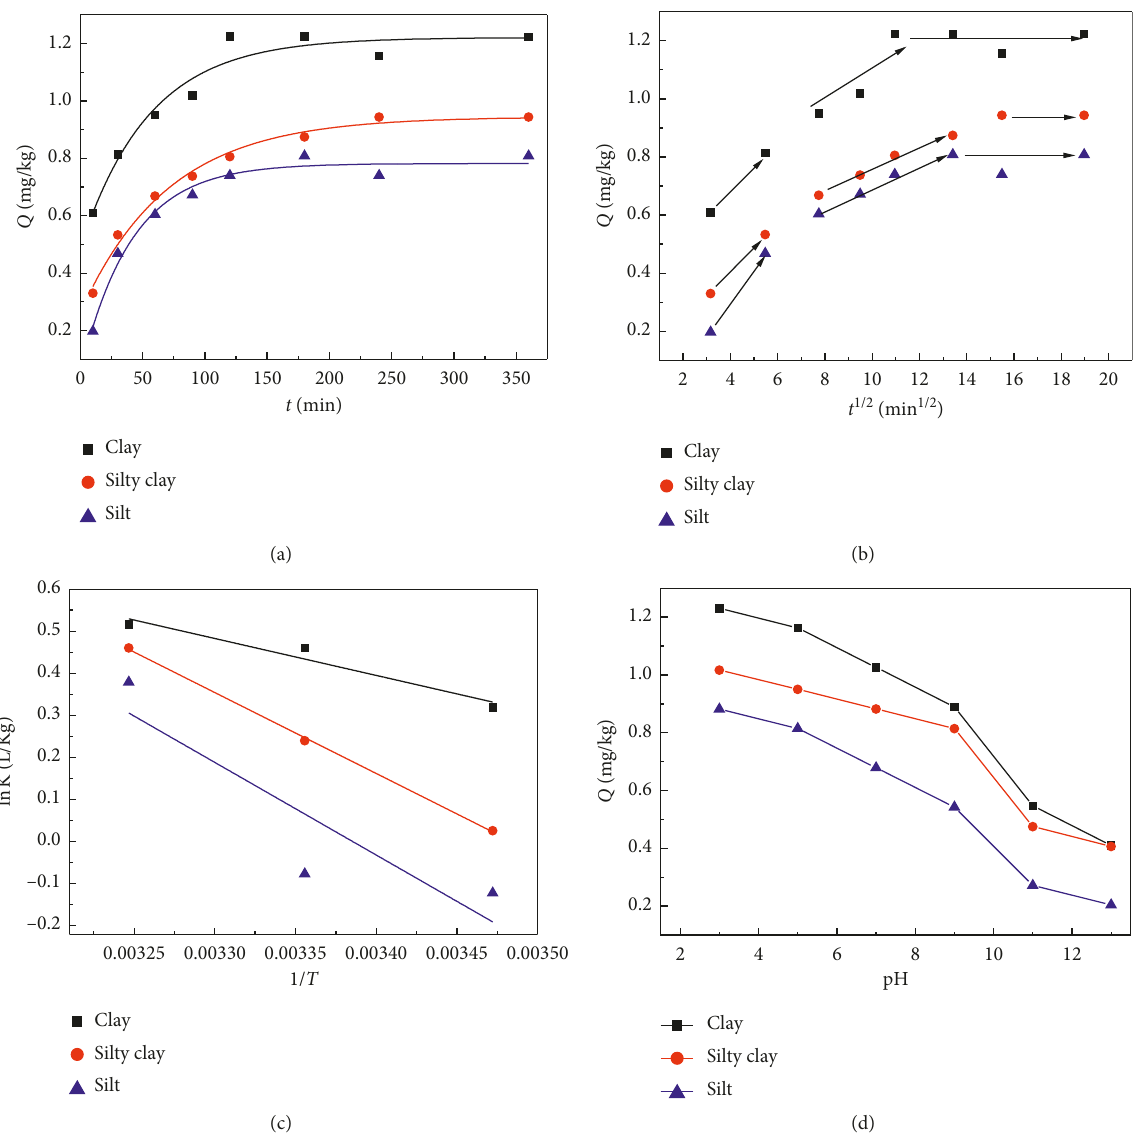
Figure 2: (a) Adsorption equilibration curves of Cr(VI) adsorption by clay, silty clay, and silt. Cr(VI) solution 1.0mg/L, aquifers 0.1g/mL, pH 7-8, and 288K. (b) Intraparticle diffusion kinetics for adsorption of Cr(VI) by clay, silty clay, and silt. Cr(VI) solution 1.0mg/L, aquifers 0.1g/mL, pH 7-8, and 288K. (c) Typical plots of ln K versus 1/ T for adsorption of Cr(VI) by clay, silty clay, and silt. (d) Effect of pH on Cr(VI) adsorption by clay, silty clay, and silt. Cr(VI) solution 1.0mg/L, aquifers 0.1 g/mL, and